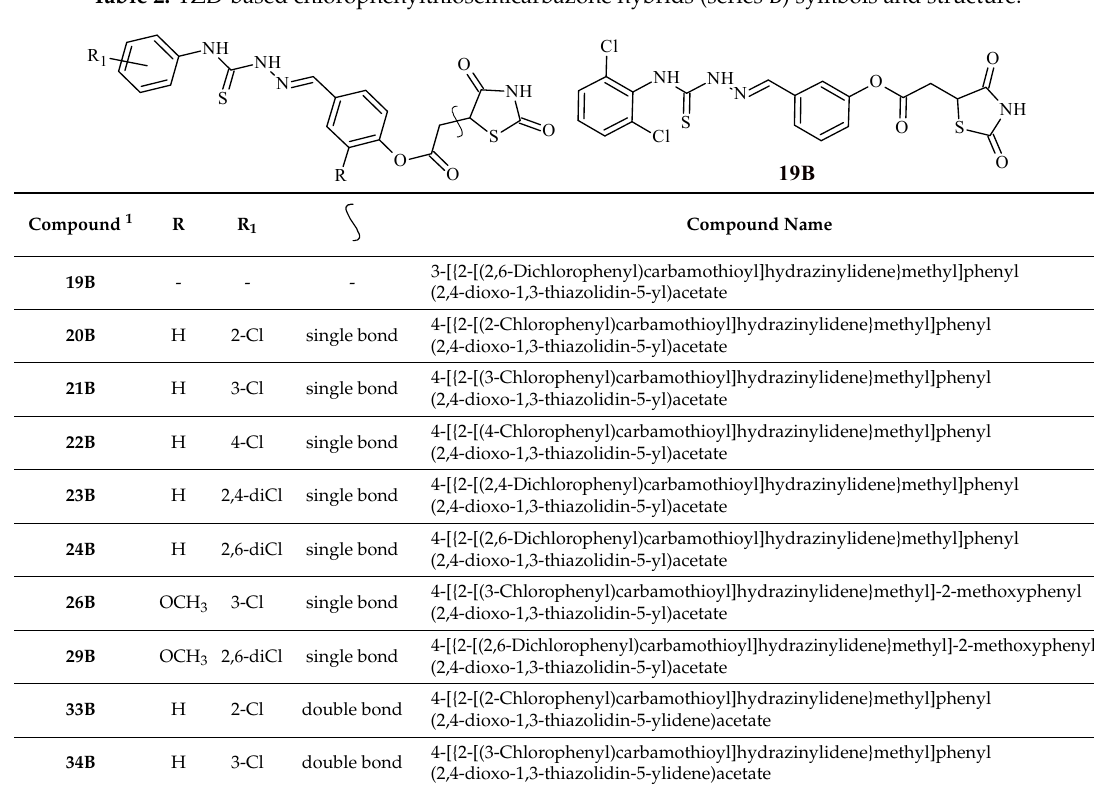
1 Number of compounds were adapted from [19]. A—TZD ‐ based azolidine hybrids. Table 2. TZD ‐ based chlorophenylthiosemicarbazone hybrids (series B) symbols and structure.